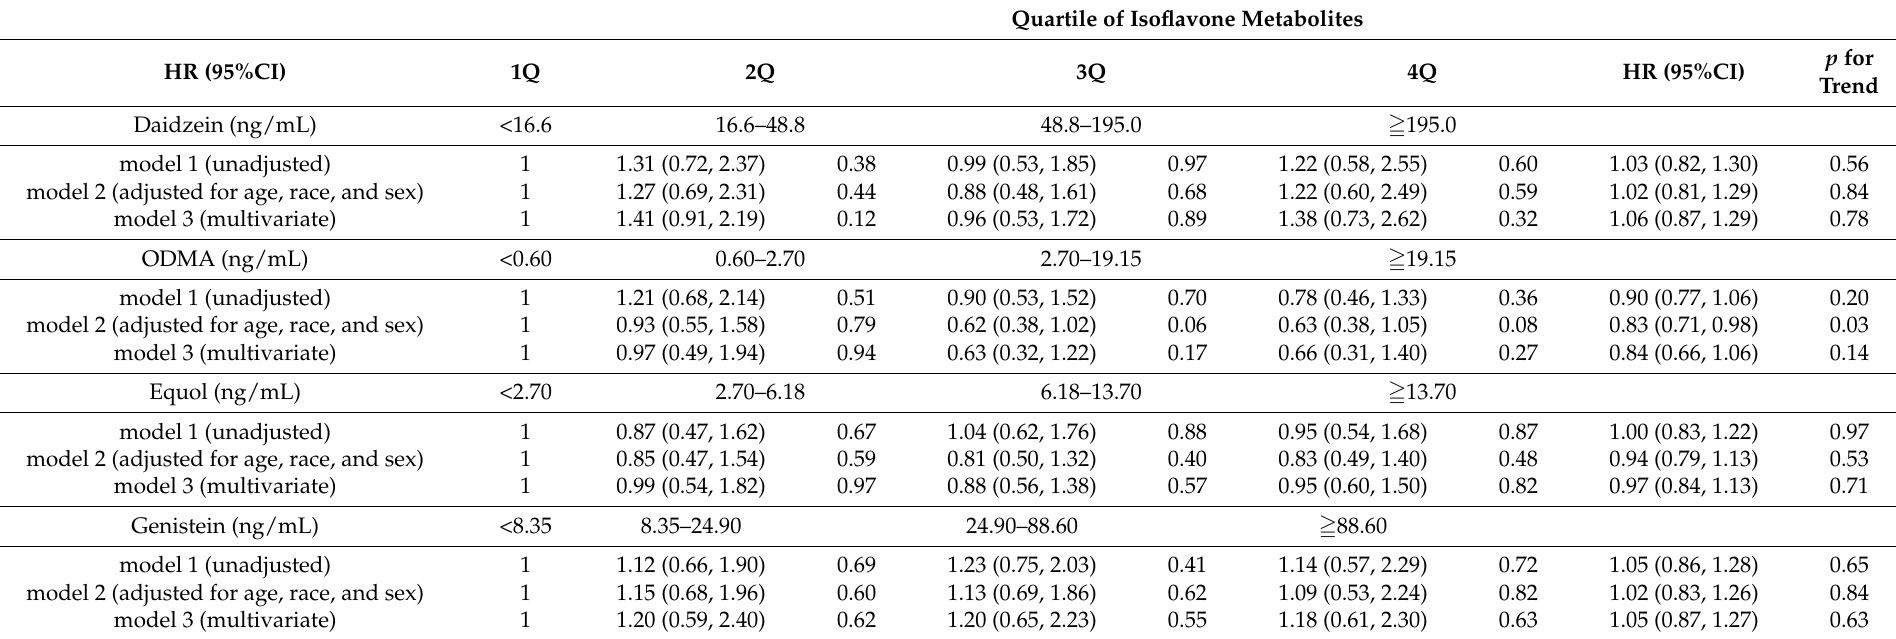
Table 6. Hazard ratios of cancer mortality by quartiles of urinary isoflavones and their metabolites.